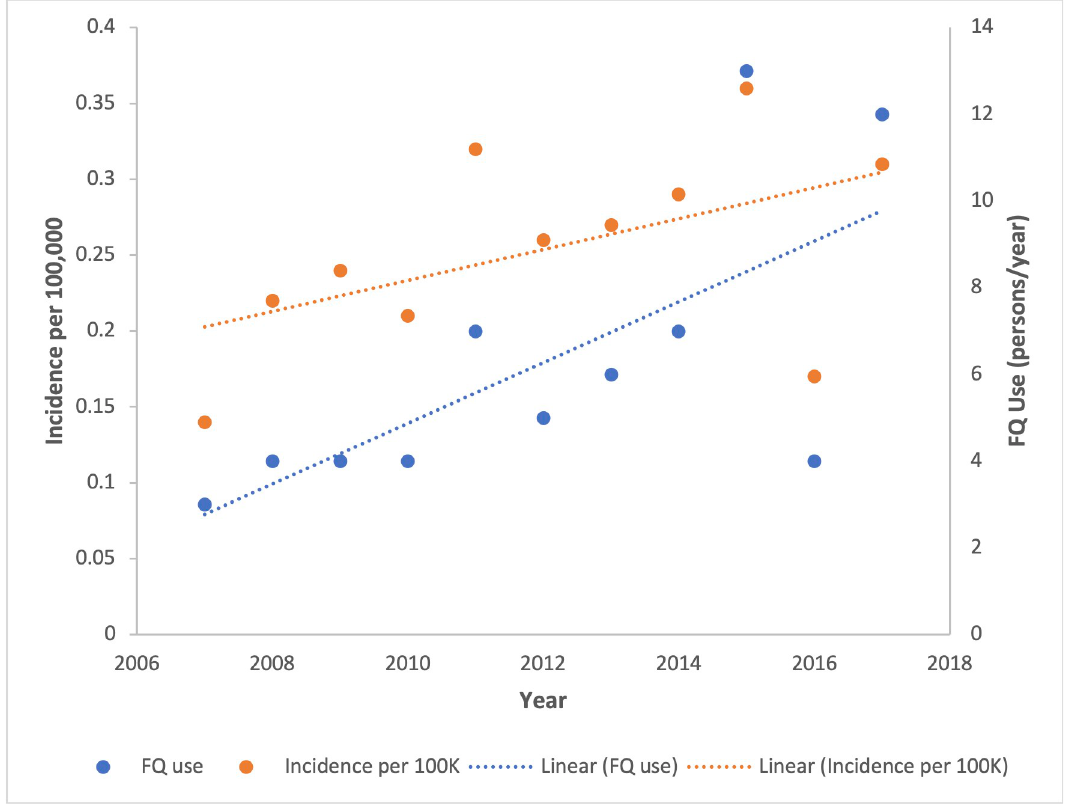
Fig 1. Incidence of Hr-TB per 100,000 per year and inclusion of fluoroquinolones in initial Hr-TB regimens per year.